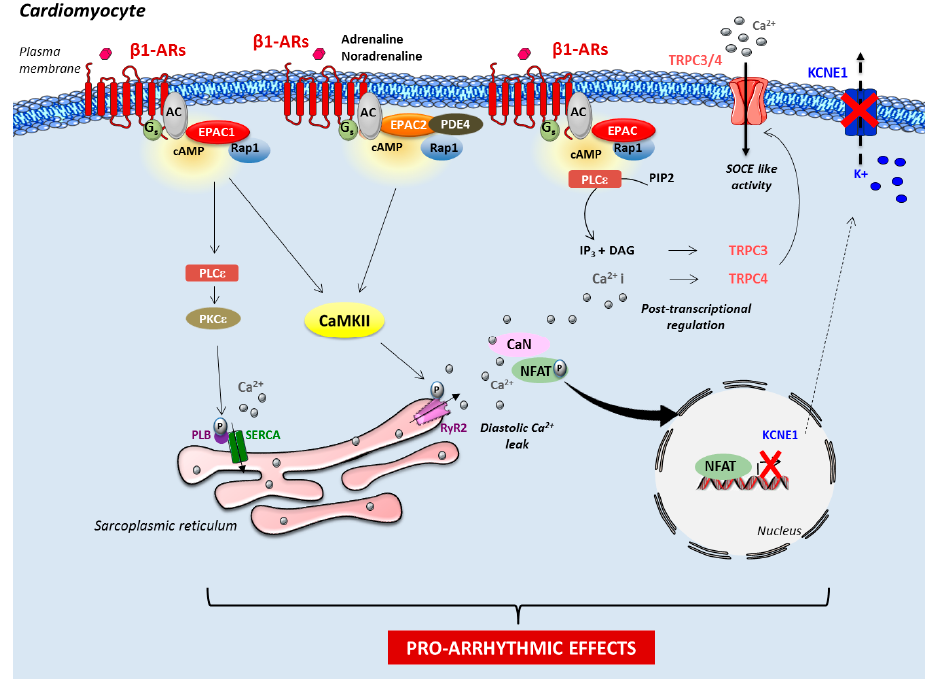
Figure 2. Role of Epac in cardiac arrhythmia. Epac proteins increase the phosphorylation state of the ryanodine receptor 2 (RyR2) via CaMKII, and subsequent Ca 2+ leak from the sarcoplasmic reticulum (SR) may trigger arrhythmia. Epac1-induced hyperphosphorylation of phospholamban (PLB) may